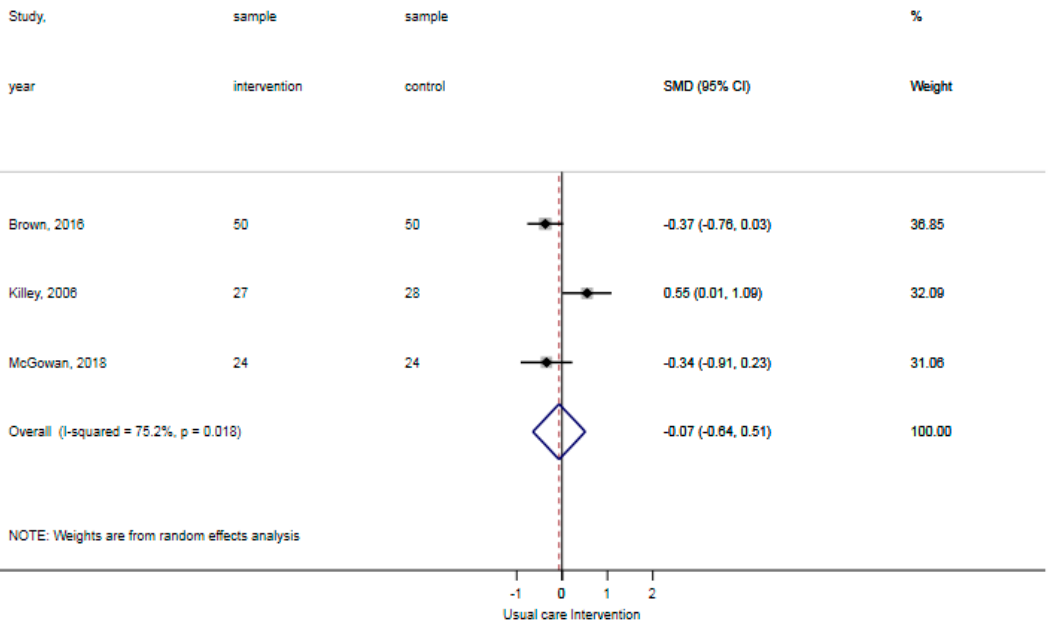
Figure 2. Forst plot activities of daily living (ADL)-activity performance showing no statistically significant difference between usual care and intervention.